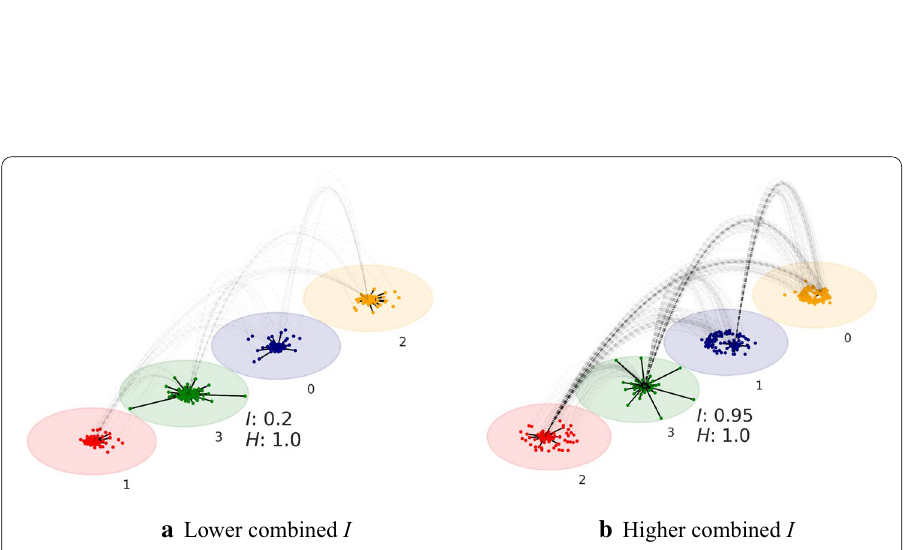
Fig. 21 Visualization of both inner-layer and coupling edges in synthetic coupled multilayer